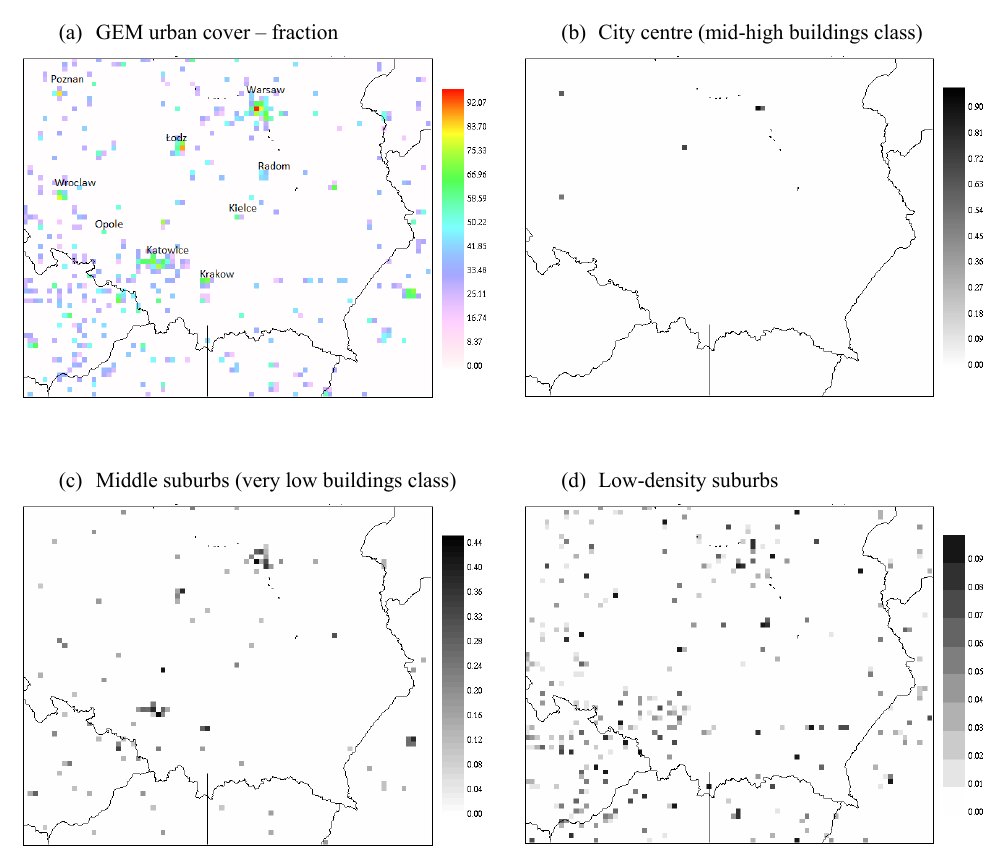
Figure 2. Urban description – original dataset and input layers for TEB (a) urban fraction – default GEM input data generated from the GenGeo interface for the nested LAM grid; (b) “city centre”; (c) “middle suburbs”; (d) “outer suburbs”.